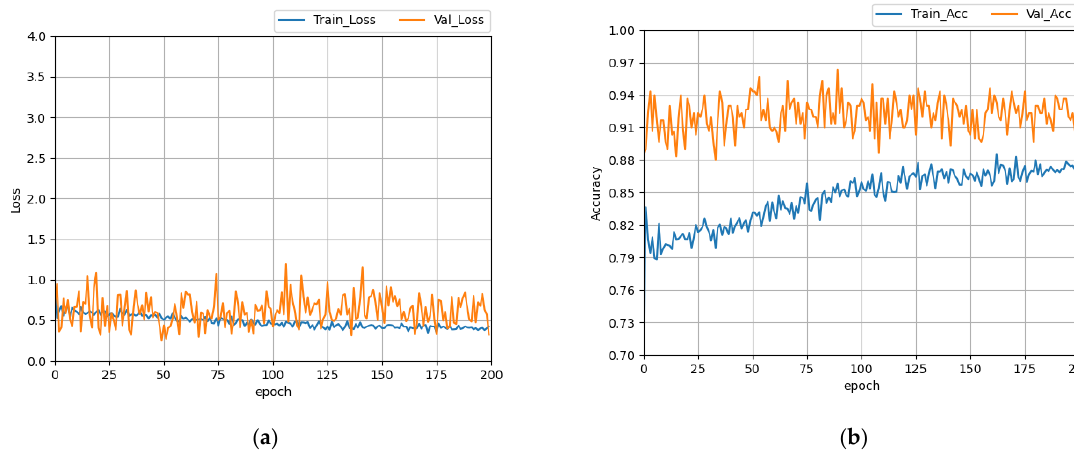
Figure A7. Stage 2 training result of the proposed learning method with the ArcFace. ( a ) loss; ( b ) accuracy.